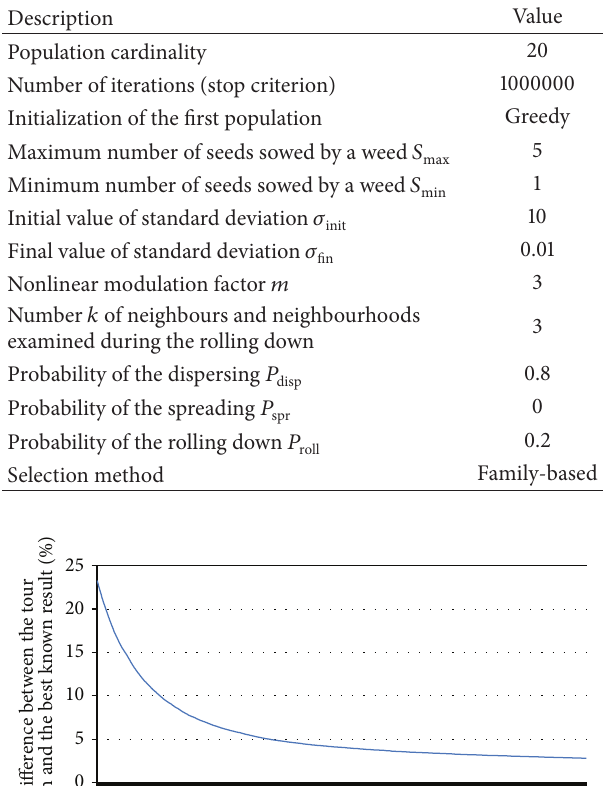
Table 8: The exIWO parameters used for the Mona Lisa TSP Challenge.